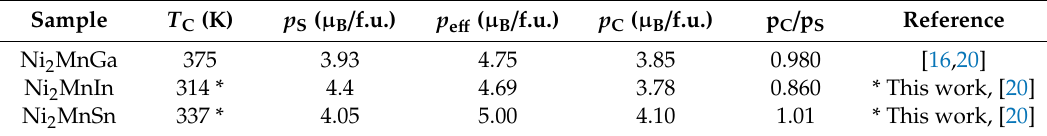
Table 3. Magnetic parameters of ferromagnetic Heusler alloys. p C indicates the magnetic moment at the paramagnetic phase. The relationship between p e ff and p C is defined by the equation of (cid:112) p ef f = p C ( p C + 2 ) . Sample T C (K) p S ( µ B /